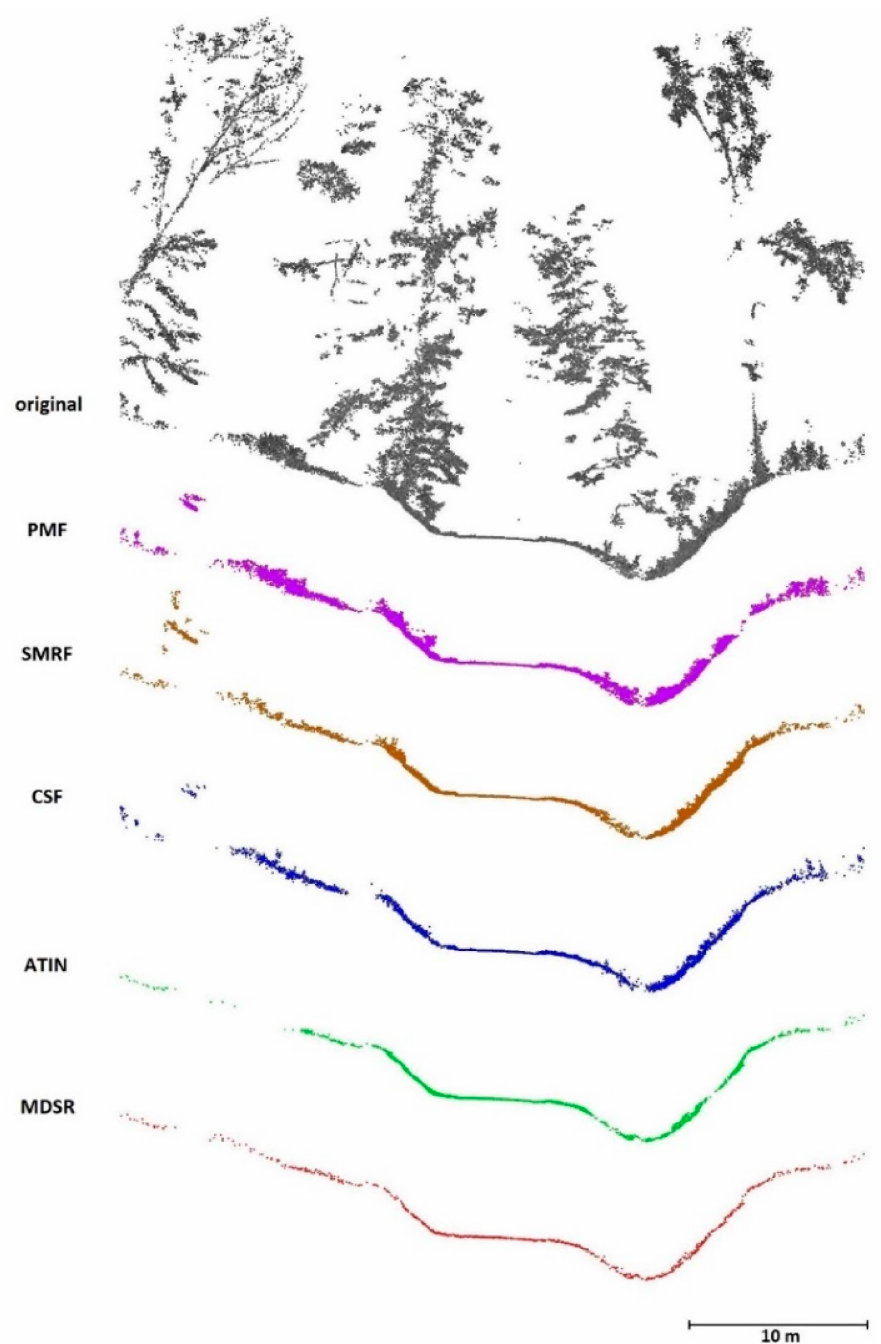
Figure 8. Profiles from site 2 filtering: gray—original cloud; purple—PMF; brown—SMRF; blue—CSF; green—ATIN;